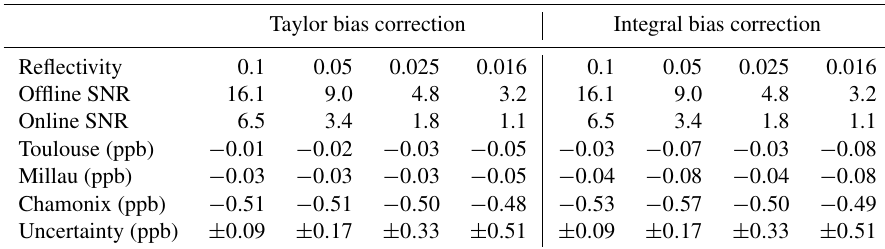
Table 7. Resulting bias (in ppb) for the AVS scheme after noise induced bias correction and geophysical induced bias correction.